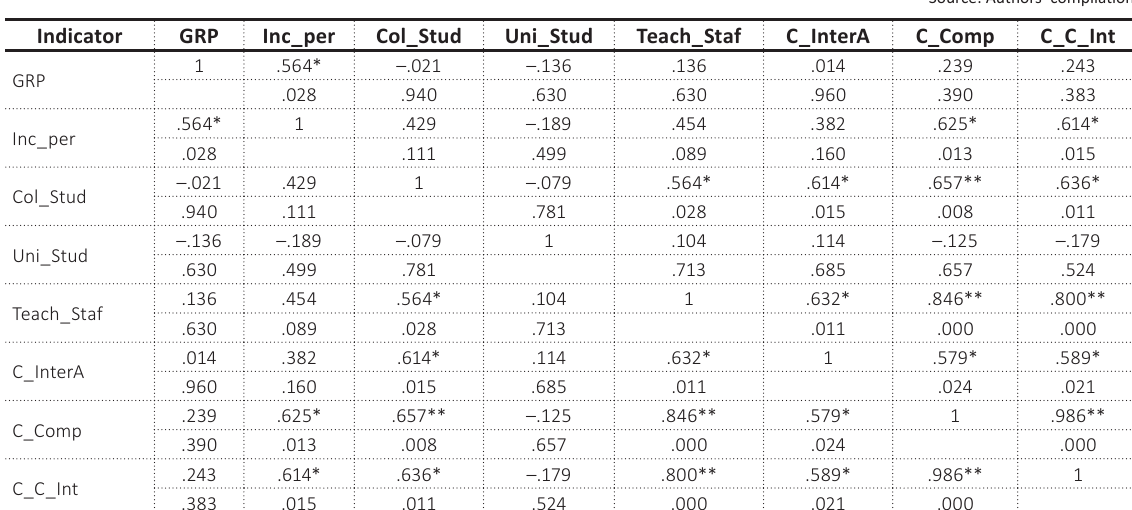
Table 5. Spearman’s rho Correlation matrix – 2015 / Sig. (2-tailed)